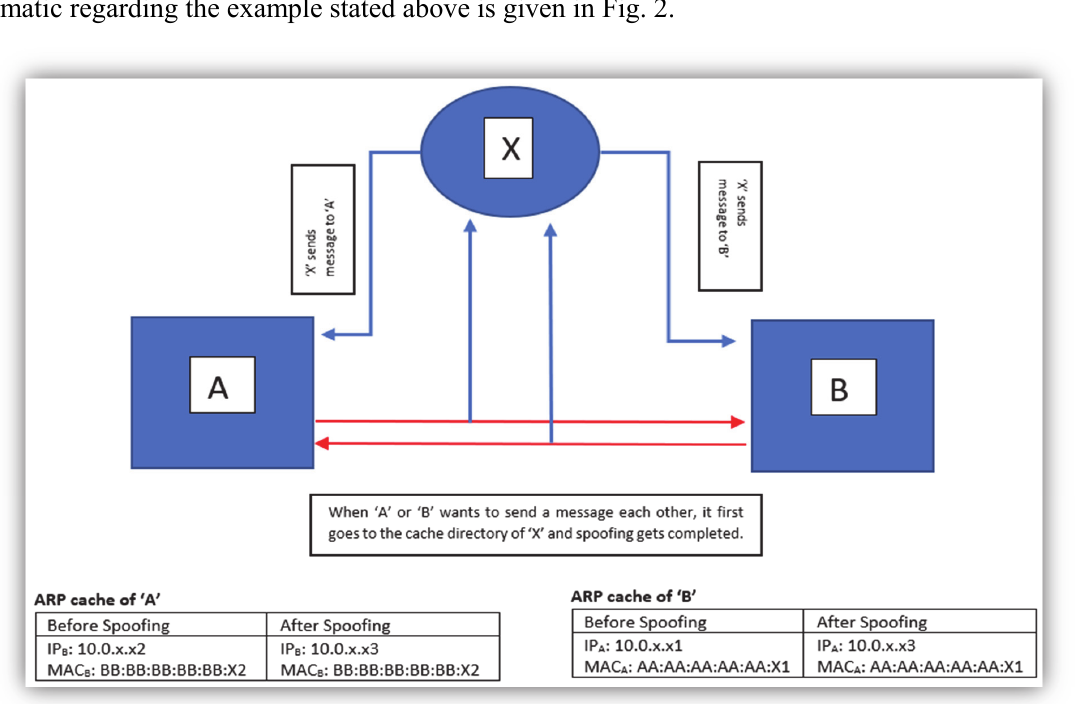
Fig. 2. Spoofing method between two